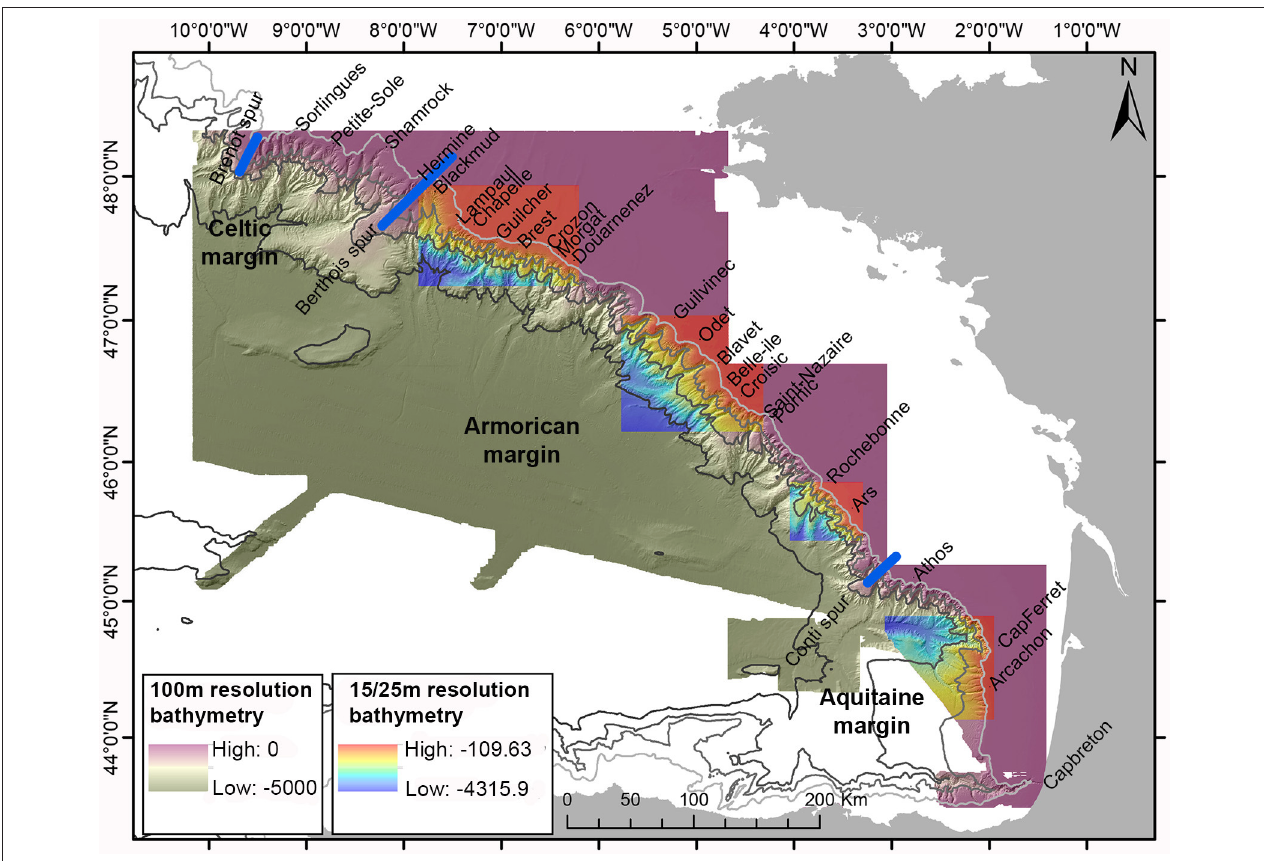
FIGURE 1 | A map of the submarine canyons incising the continental slope of the Bay of Biscay. The bathymetry is available at a 100m resolution for the whole Bay of Biscay (green-purple) and at a 15/25m resolution for four boxes representing each zone (rainbow-colored) from Bourillet et al. (2012). The blue lines indicate the Brenot, Berthois and Conti spurs, dividing the margin into the Celtic, Armorican and Aquitaine margins.